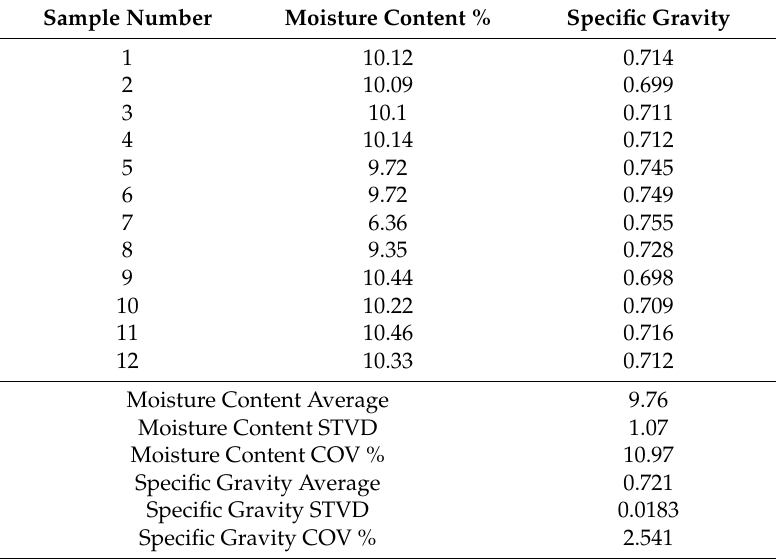
Table 3. Moisture Content and Specific Gravity Data.